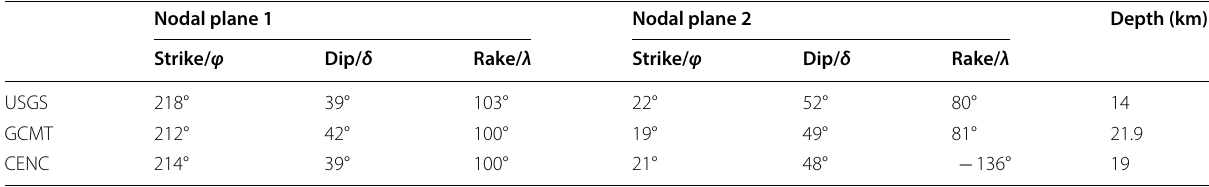
Table 2 Focal mechanism of the 2013 Lushan earthquake Nodal plane